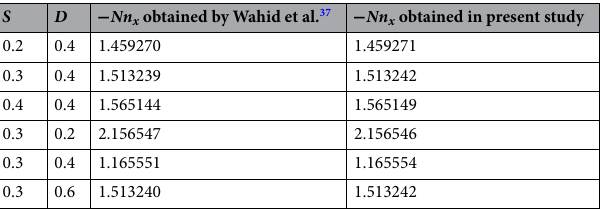
Table 3. Comparison of obtained numerical entities of